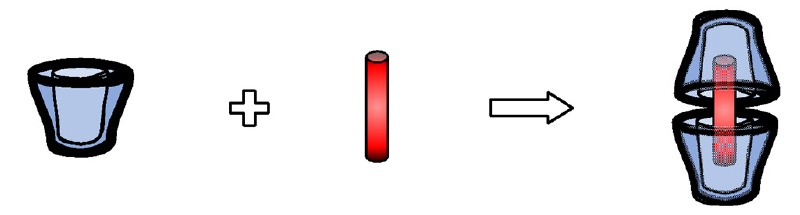
Figure 3. Formation cyclodextrin—drug inclusion complexes [35].